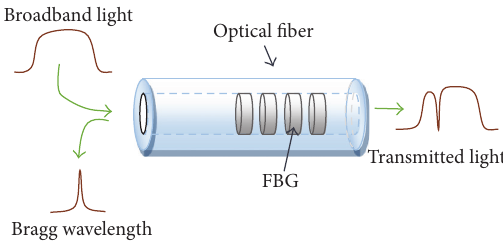
Figure 1: Fiber Bragg